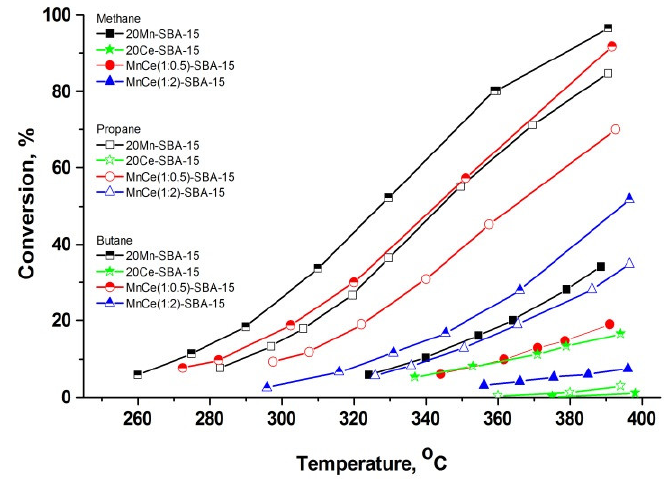
Figure 11. Temperature dependence of methane, propane and butane combustion. Obviously, the lowest values for T 50 were observed in the case of butane (T 50 = 326 ◦ C) on the mono-component Mn-SBA-15 sample. It should be specified that in the case of methane and temperatures below 450 ◦ C, the conversion degree of 50% was measurable for the Mn-20 sample only: T 50 = 407 ◦ C (Table 5). Table 5. Light-off temperatures (T50) of methane, propane and butane combustion in air (GHSV STP = 150,000 h –1 ) and ratios between calculated rate constants. Methane Propane Butane T 50 326